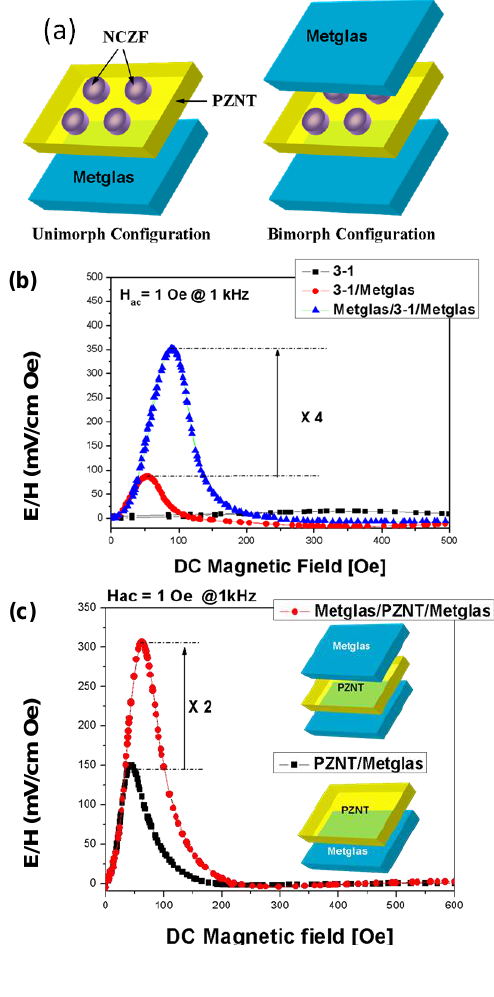
Figure 27. (a) Schematic diagrams of unimorph and bimorph configurations; (b) ME coefficient of 3-1 composite depending on the laminations: 3-1/Metglas and Metglas/3-1/Metglas; (c) ME coefficient of typical 2-2 composites based on PZNT and Metglas: unimorph and bimorph